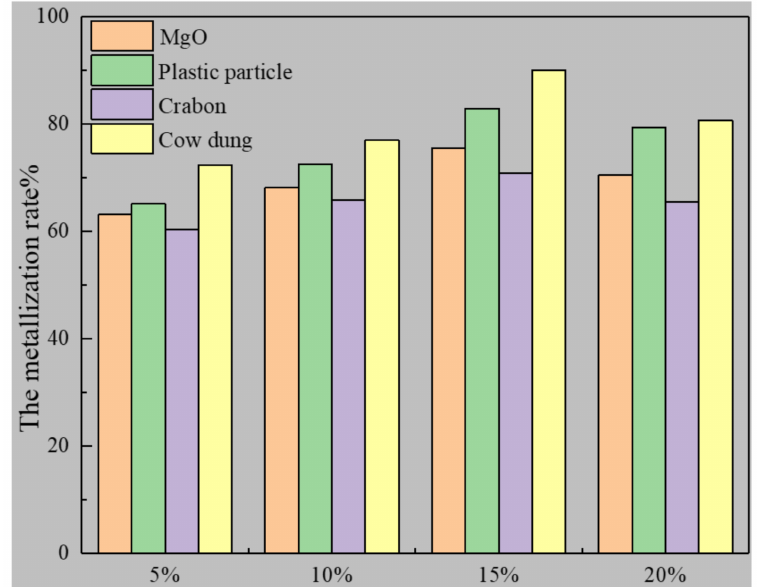
Figure 4. Comparison of metallization rates of different coating materials and contents.